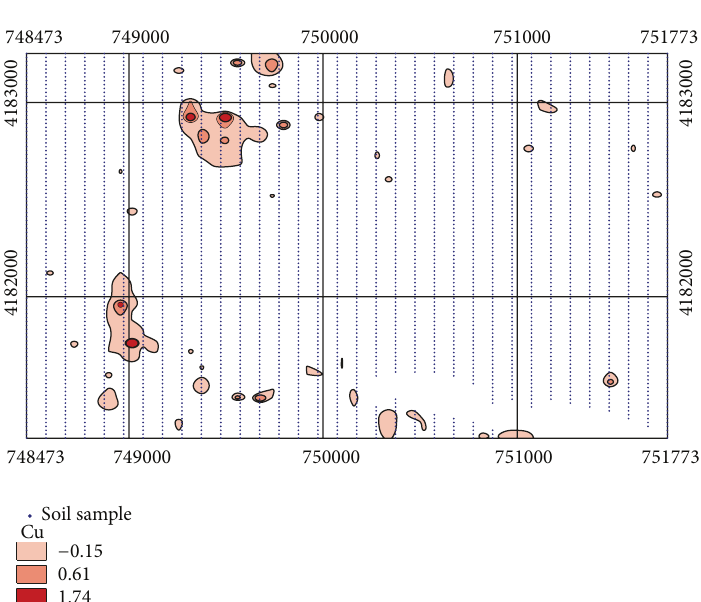
Figure 9: The isogram of Cu after processing by the